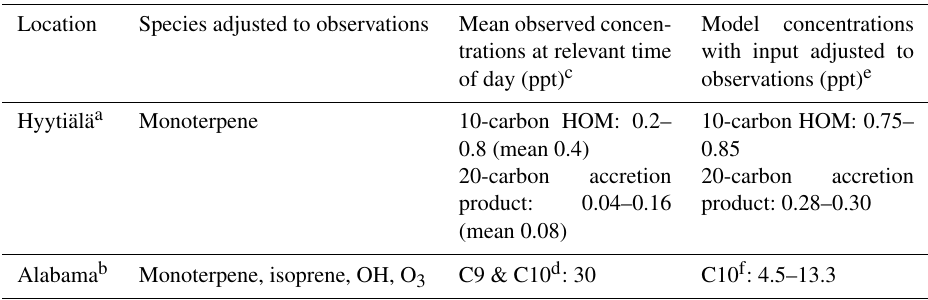
Table 5. Observed and modelled concentrations after adjustment of model input. The model performs well in comparison to observed [HOMs] at